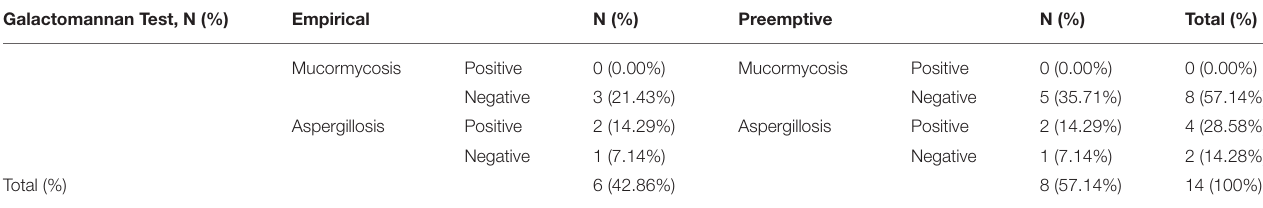
TABLE 3 | Results of galactomannan test with regard to type of therapy. Galactomannan Test, N (%)